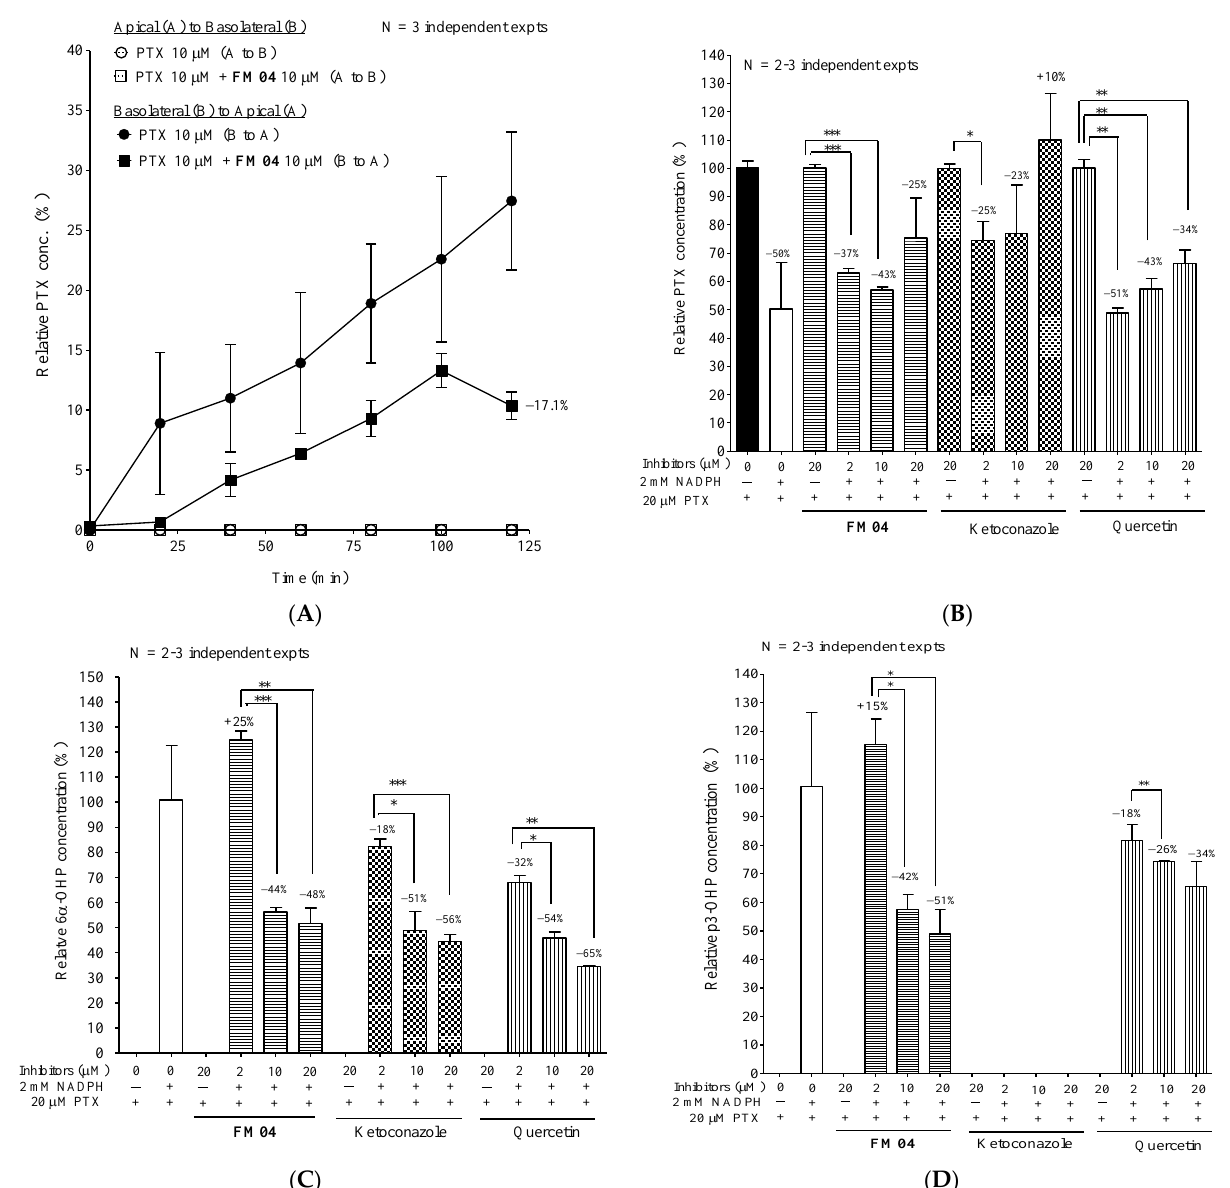
Figure 7. Mechanistic study of FM04 to increase the oral PTX absorption. ( A ) transepithelial perme- ability of PTX in Caco-2 transwell assay. When confluent monolayer of Caco2 cells was formed on the transwell, the permeability of PTX (10 μ M) was studied with or without FM04 (10 μ M). For apical to basolateral transport (A to B), compound was added at the apical side (donor) and samples of the medium collected at the basal side (receiver) at 0, 20, 40, 60, 80, 100 and 120 min and vice versa for basal to apical transport (B to A). The PTX level was determined using UPLC-MS/MS. The relative % of PTX was presented as mean ± standard error of mean. N = 2 – 3 independent experiments. Impact of FM04 on PTX metabolism. Ketoconazole and quercetin, known inhibitors of CYP2C8 or 3A4 metabolic enzymes, were included in the assay. PTX at 20 μM was incubated with a series concentration of FM04 , ketoconazole or quercetin (2, 10 and 20 μM) in human liver microsomes with or without NADPH, respectively. After incubation, the levels of PTX, metabolites 6α -hy- droxpaclitaxel (6α - OHP) and p3′ -hydroxpaclitaxel (p3-OHP) were determined by HPLC-MS/MS. ( B ) changes in PTX. ( C ) changes in 6α -OHP. ( D ) changes in p3-OHP. Relative concentration (%) of PTX, 6α -OHP and p3-OHP were presented as mean ± standard error of mean. N = 2 – 3 independent experiments. Statistical an alysis was performed by using Student’s t -test, *, p < 0.05; **, p < 0.01; ***, p < 0.001.